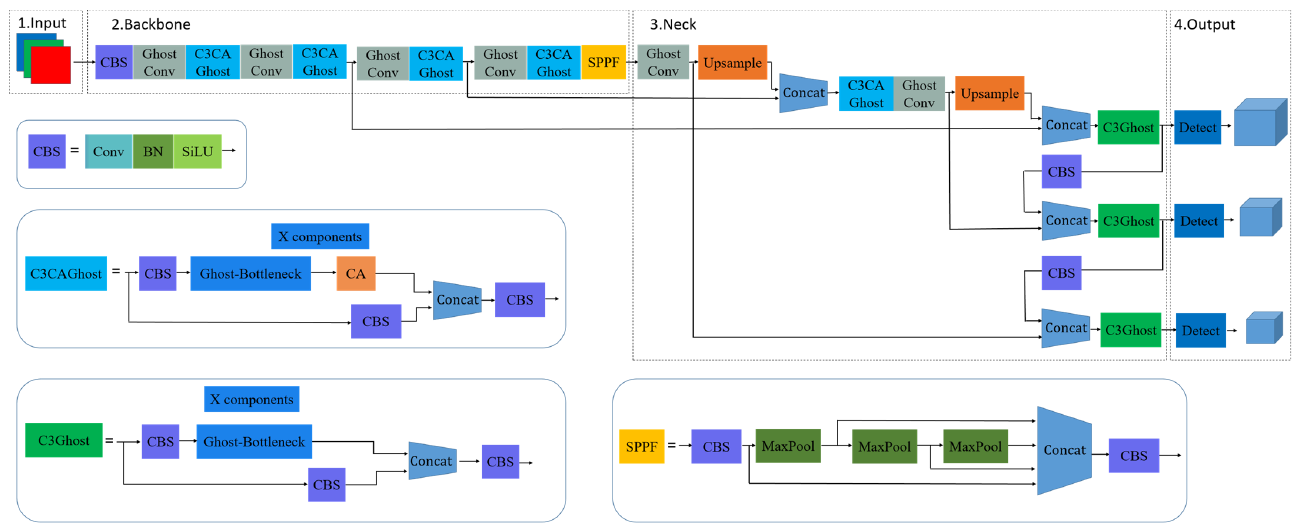
Figure 7. Structure of the improved YOLOv5 model.